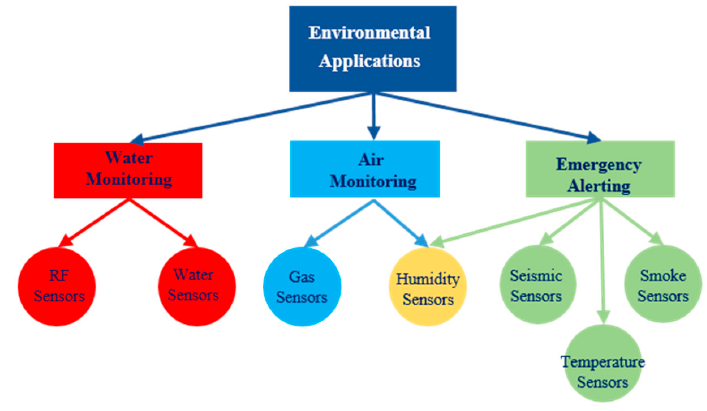
Figure 10. The subcategories of the environmental WSN applications and the types of the sensors used in them.